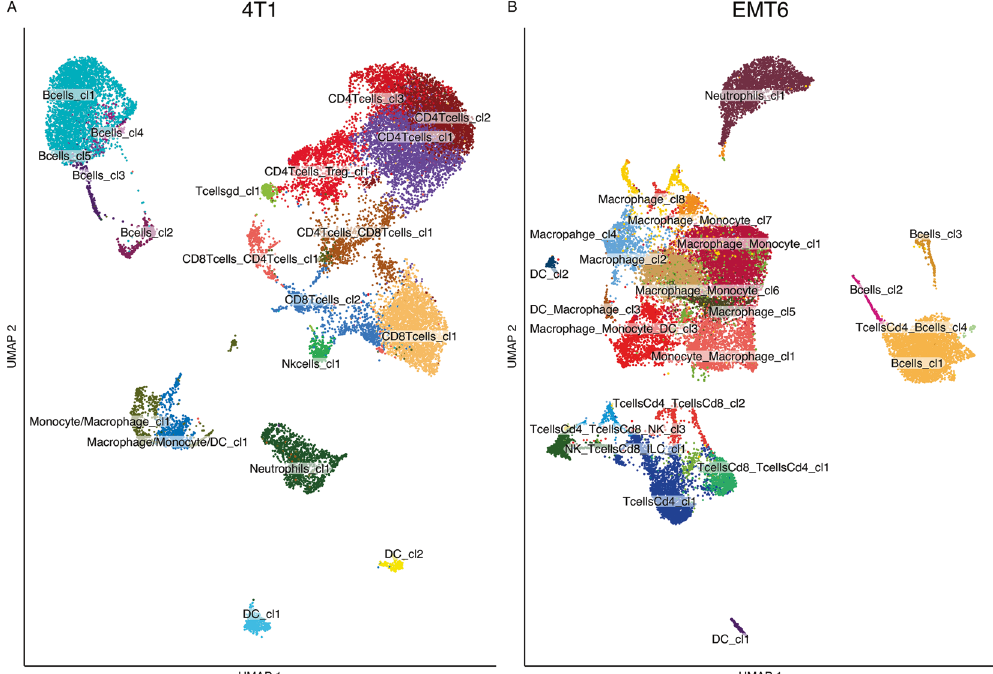
Fig. 1 Immune cellular landscape in the two mouse TNBC TMEs. A UMAP of 22,403 immune cells in 4T1 TME grouped in 20 clusters. Each dot refers to a cell. The colors refer to the label assigned to the clusters. B UMAP of 26,245 immune cells in EMT6 TME grouped in 22 clusters. Each dot refers to a cell. The colors refer to the label assigned to the